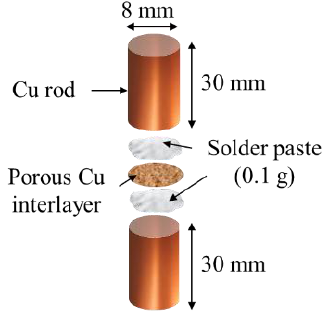
Figure 2. Configuration of a solder joint.